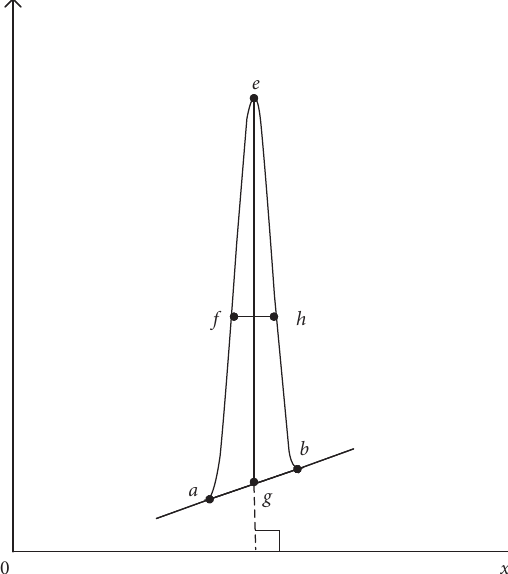
Figure 10: Schematic diagram of peak area calculation